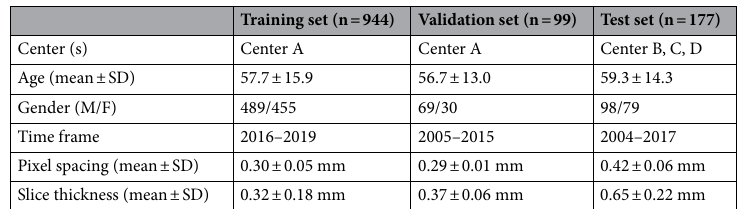
Table 1. Data set characteristics. N number, SD standard deviation, M male, F female.